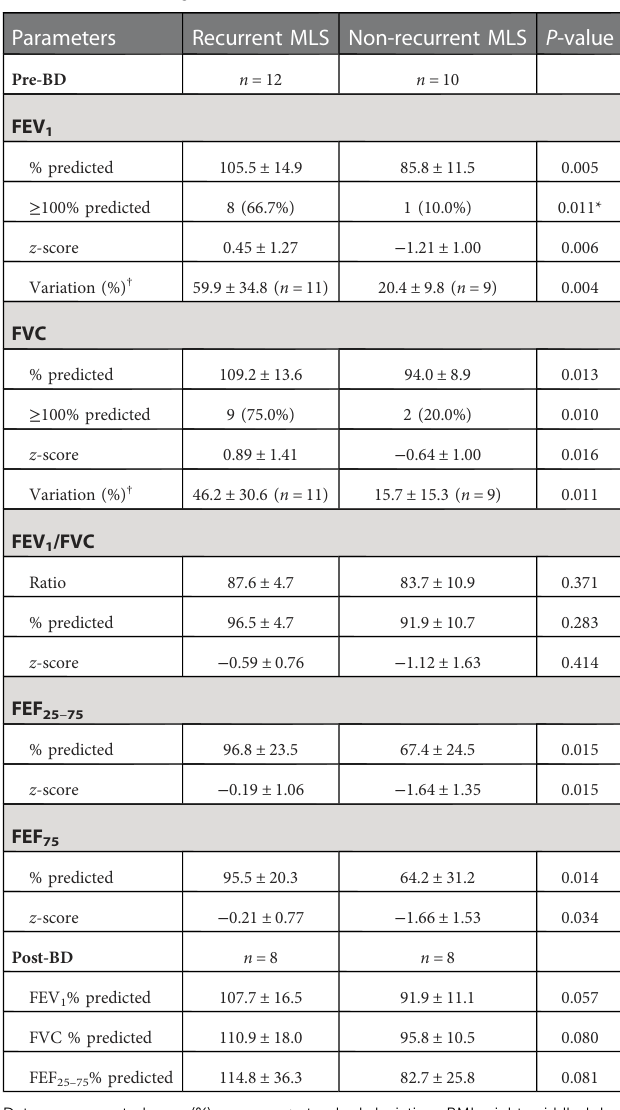
TABLE 5 Spirometry of asthmatic children with RML and/or lingula atelectasis strati fi ed by recurrent